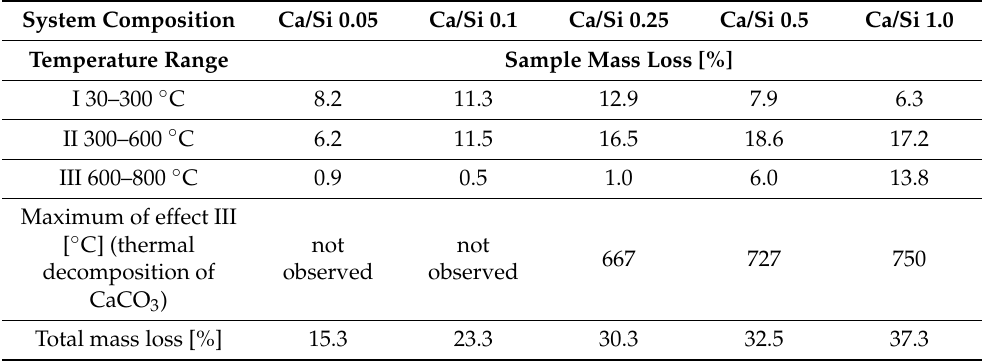
Table 3. Quantitative mass loss of the Ca/Si systems during thermogravimetric analysis.